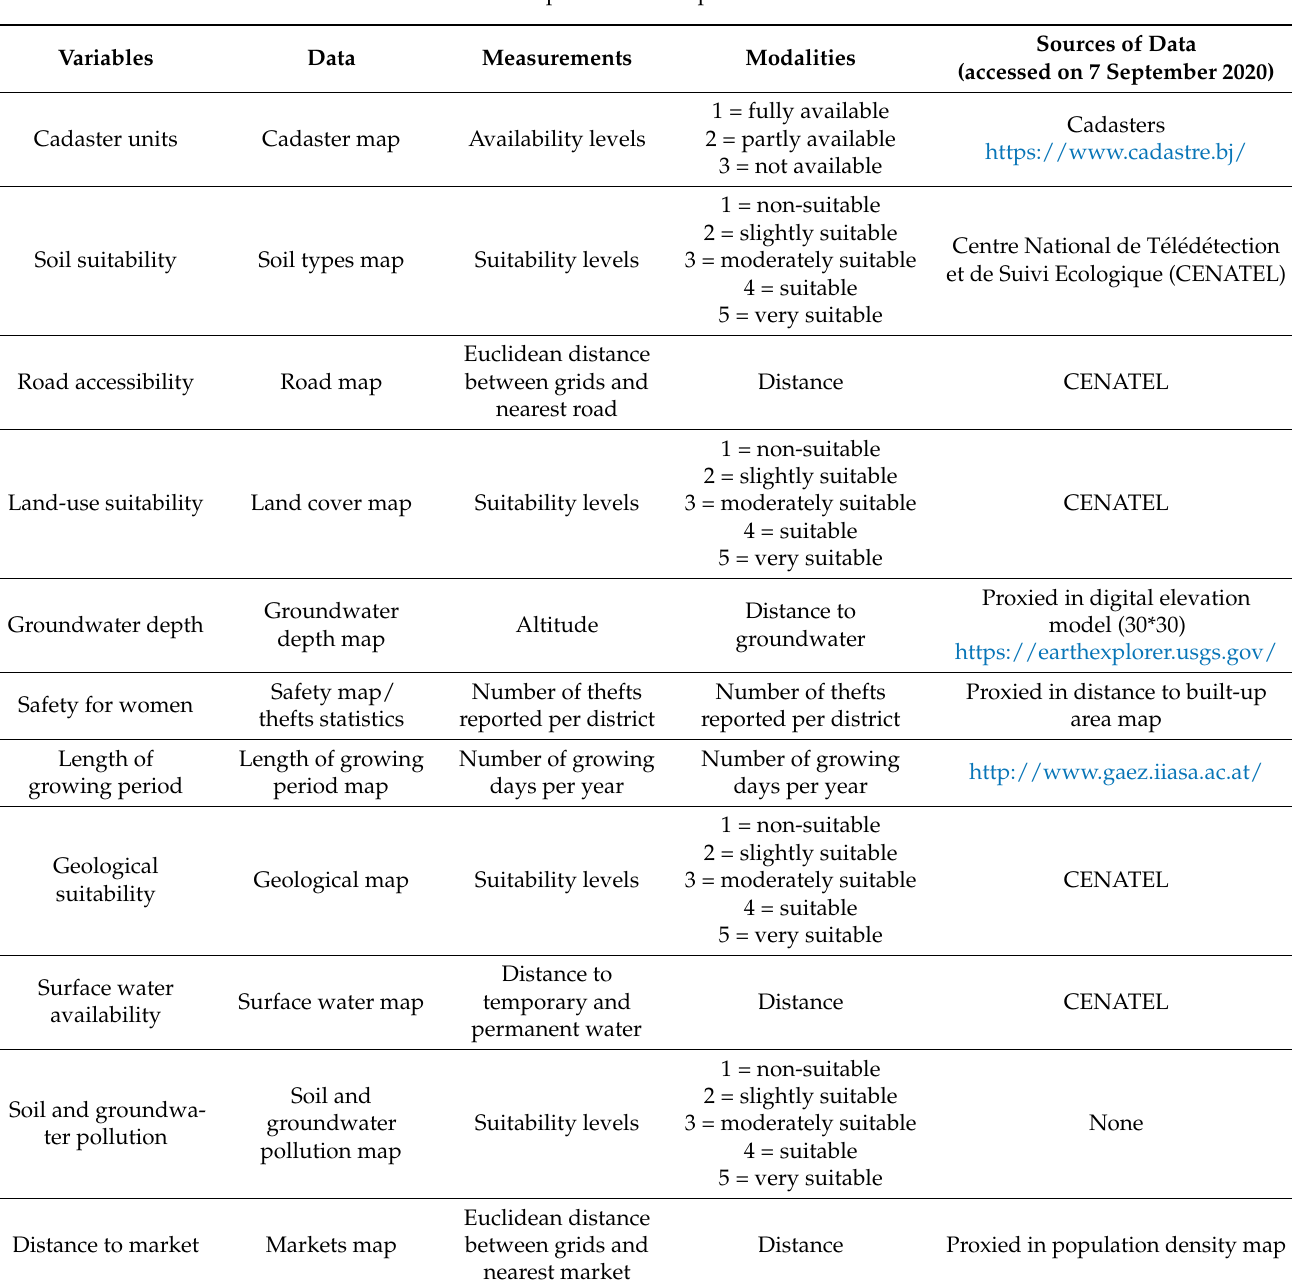
Table 1. Compilation of independent variables.